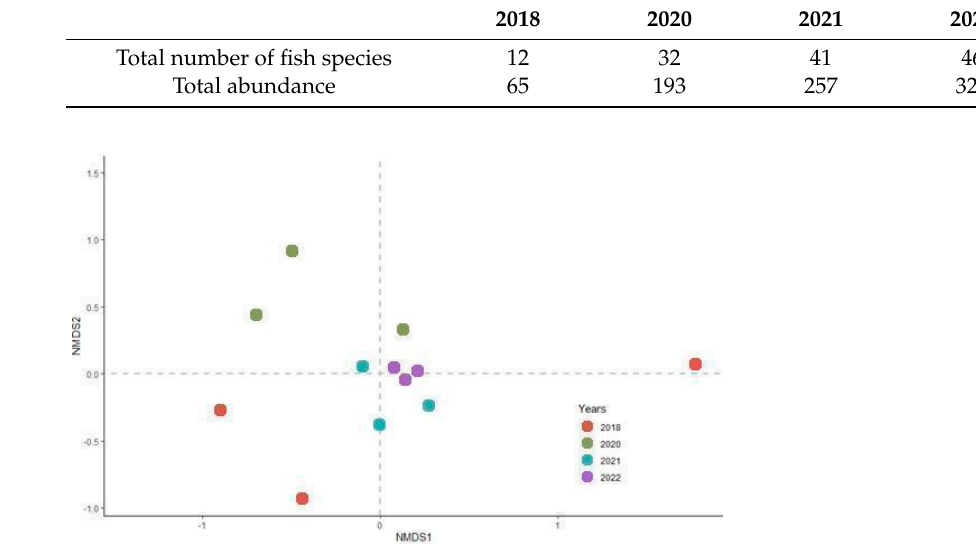
Figure 6. Non-metric multidimensional scaling (NMDS) using Bray-Curtis dissimilarities of fish community on permanent transects at MOUA from 2018 to 2022 (2D stress value = 0.08). Table 4. PERMANOVA (permutational multivariate analysis of variance) with a 4th root transfor- mation testing for a difference in the biodiversity of fish at Coral Greenhouse across time. A million permutations were used with the transect as a blocking factor. p -values were adjusted to account for repeated cases using the Benjamini and Hochberg method (1995). Significant values in bold . Fish